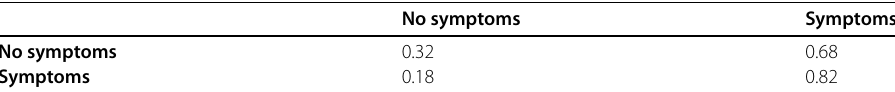
Table 4 The confusion matrix for the two-class classification